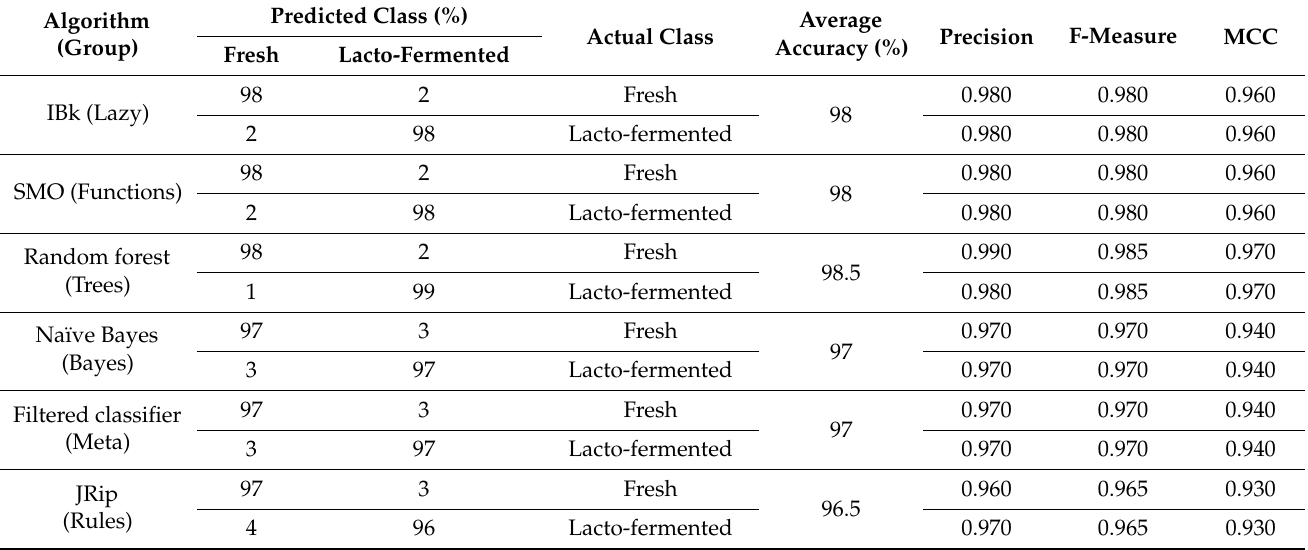
Table 3. The results of discrimination of fresh and lacto-fermented red bell pepper samples using selected image textures from color channel L